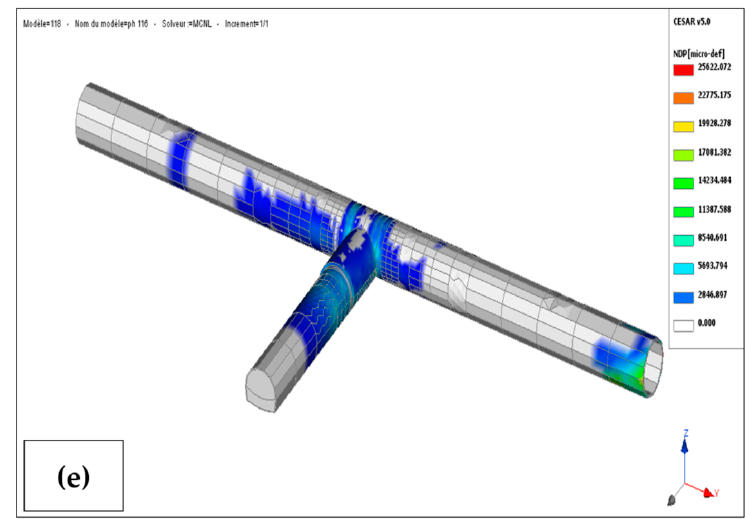
Figure 7. Effect of umbrella arch technique on the distribution of the plastic zone at the final construction step. ( a ) Before the cross ‐ passage excavation, ( b ) After the cross ‐ passage excavation (without reinforcement), ( c ) with reinforcement L = 8 m, ( d ) with reinforcement L = 10 m, ( e ) with reinforcement L = 12 m.